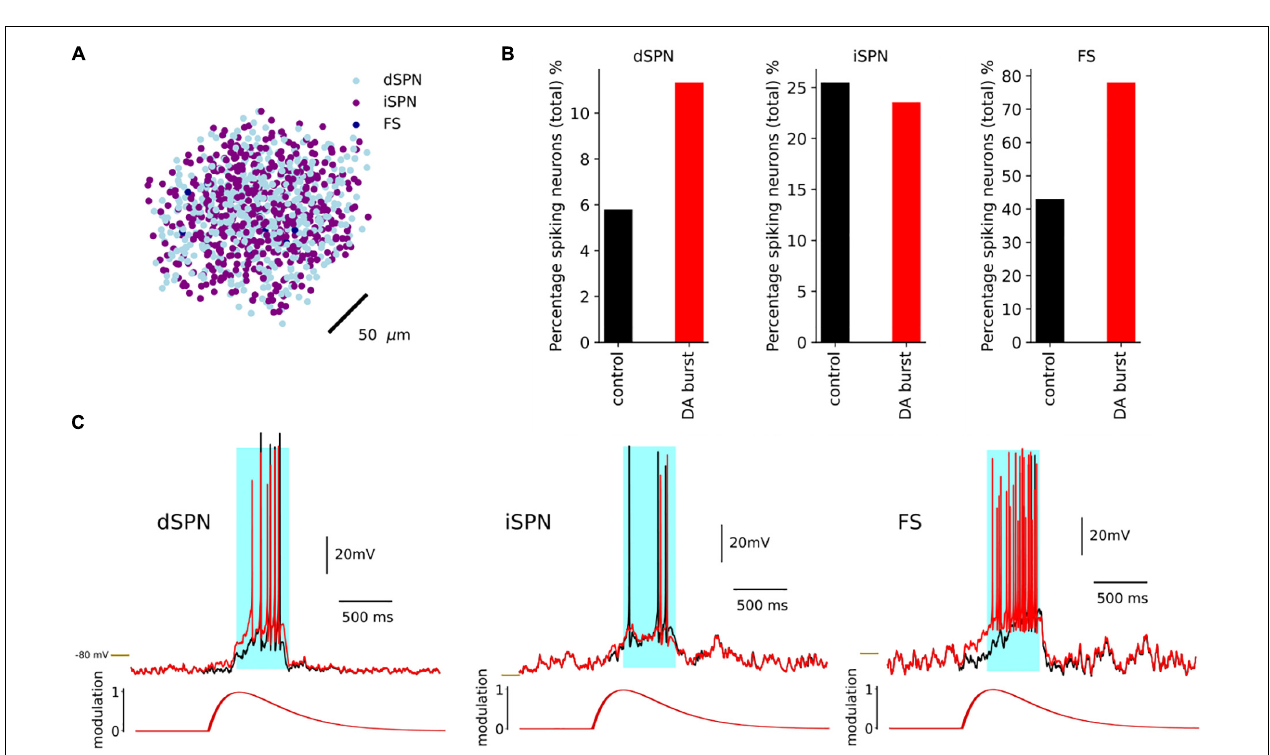
FIGURE 8 | Simulation of dSPN with and without DA within a network of 10 000 neurons with 4950 dSPNs and iSPNs and 100 FS. (A) A network of 10,000 neurons. Here we plot the soma positions. A dopamine transients was initiated at 0.5 and a cortical stimulation at 1 s. (B) The response of dSPN with the dopamine modulation in red and the control in black. The dopamine modulation causes a depolarization in the dSPN which results in an increase in the percentage of spiking dSPNs. The iSPN responded with a decrease in the percentage of spiking neurons, while FS increased. (C) Examples of dSPN, iSPN and FS models and the response with dopamine modulation (red) and control (black), with cortical stimulation in light blue. –80 mV marked by yellow line.